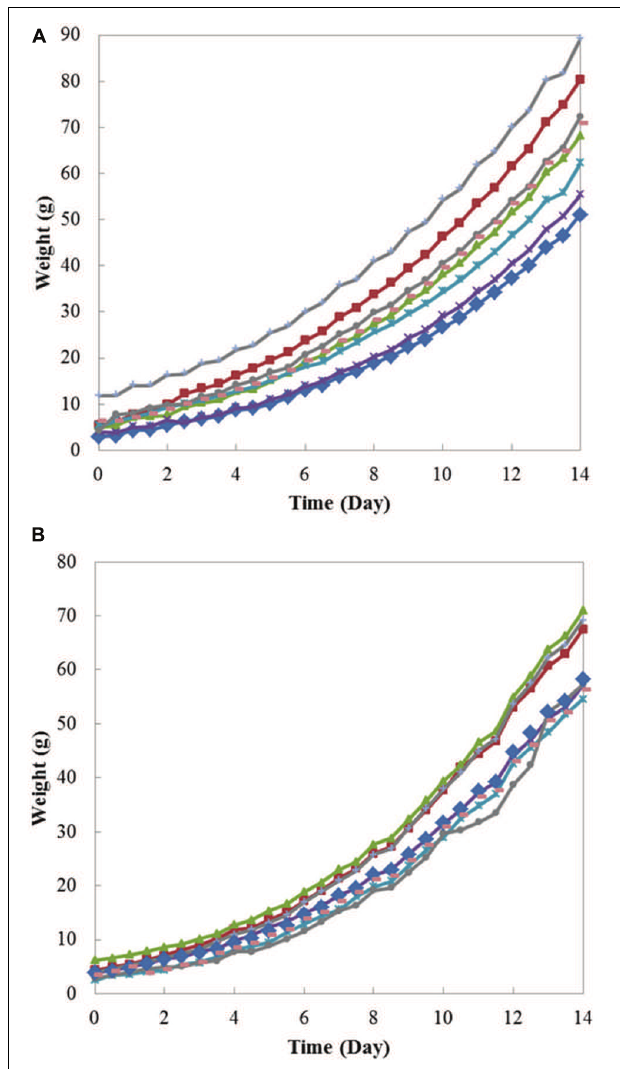
FIGURE 5 | Plant weight growth curves of (A) eight Boston lettuces and (B) eight coral